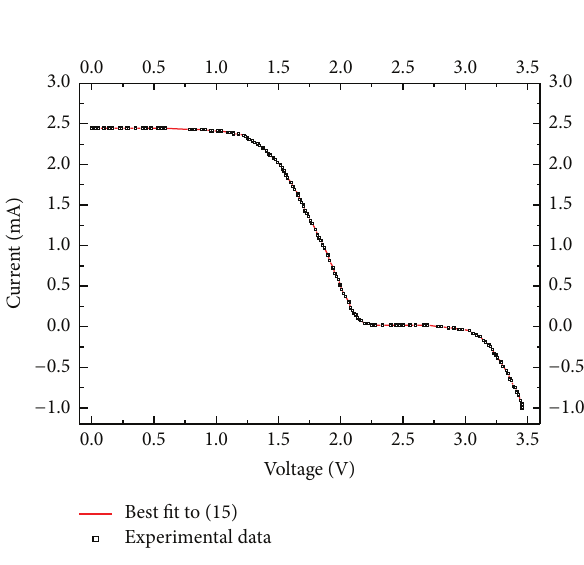
Figure 7: Experimental data of I-V characteristics of a four-cell module with one fully shadowed